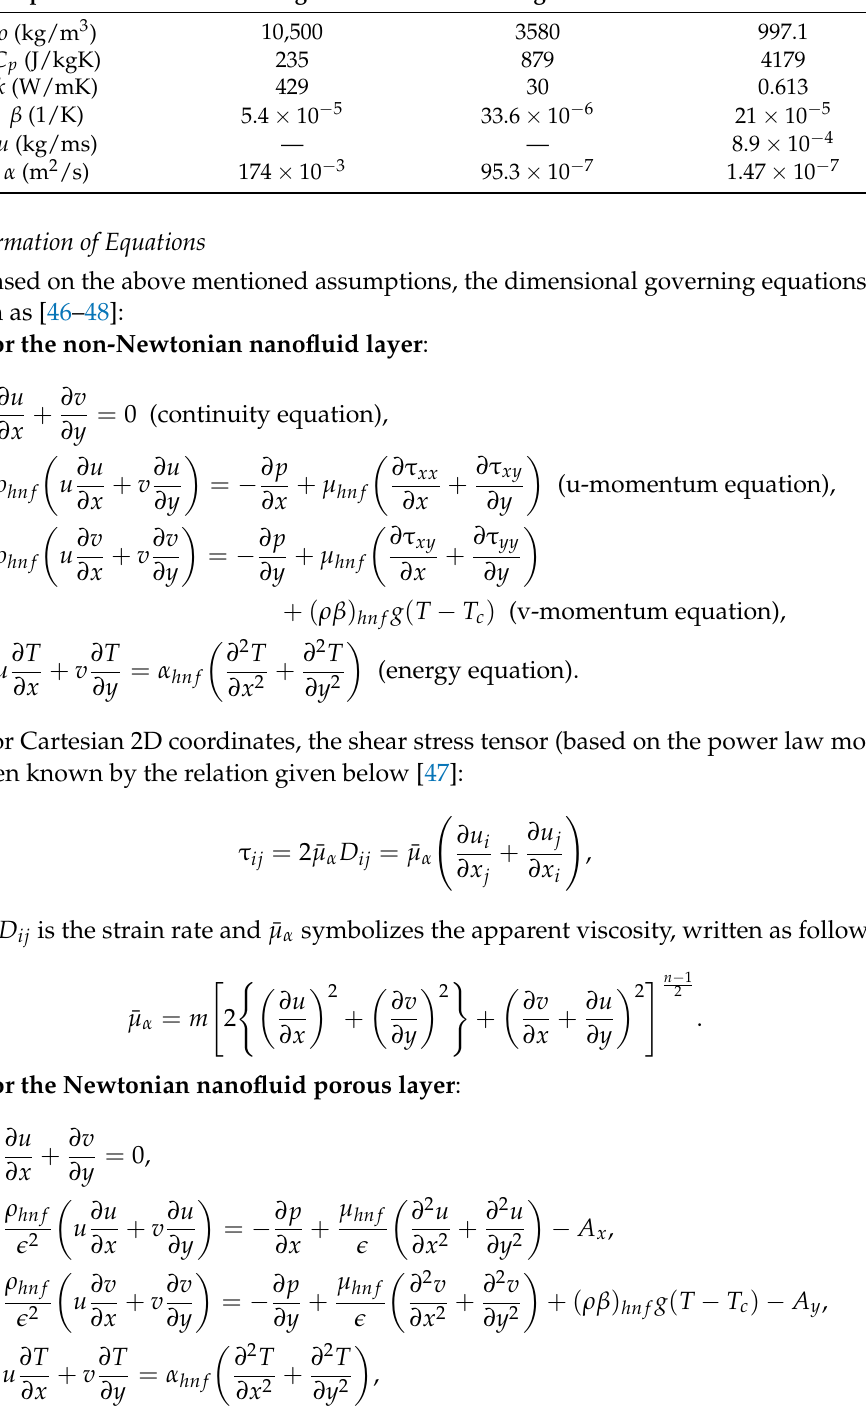
Table 1. Thermophysical properties of alumina and copper [45,46].